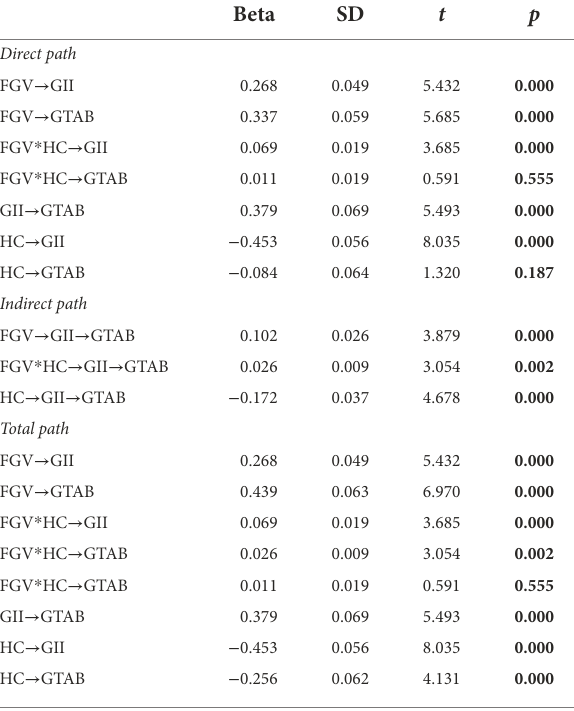
TABLE 4 Direct, indirect, and total path estimates.